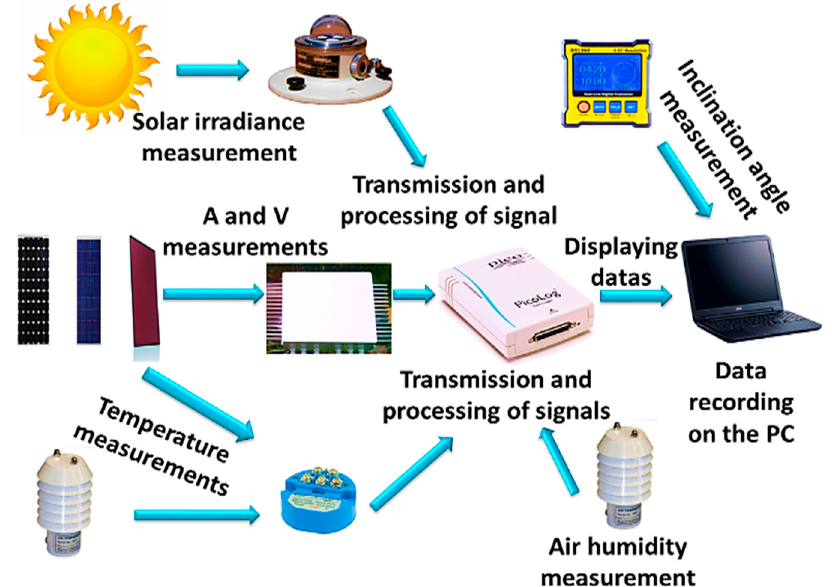
Figure 5. Schematic illustration of PV module measuring station ‘A’.